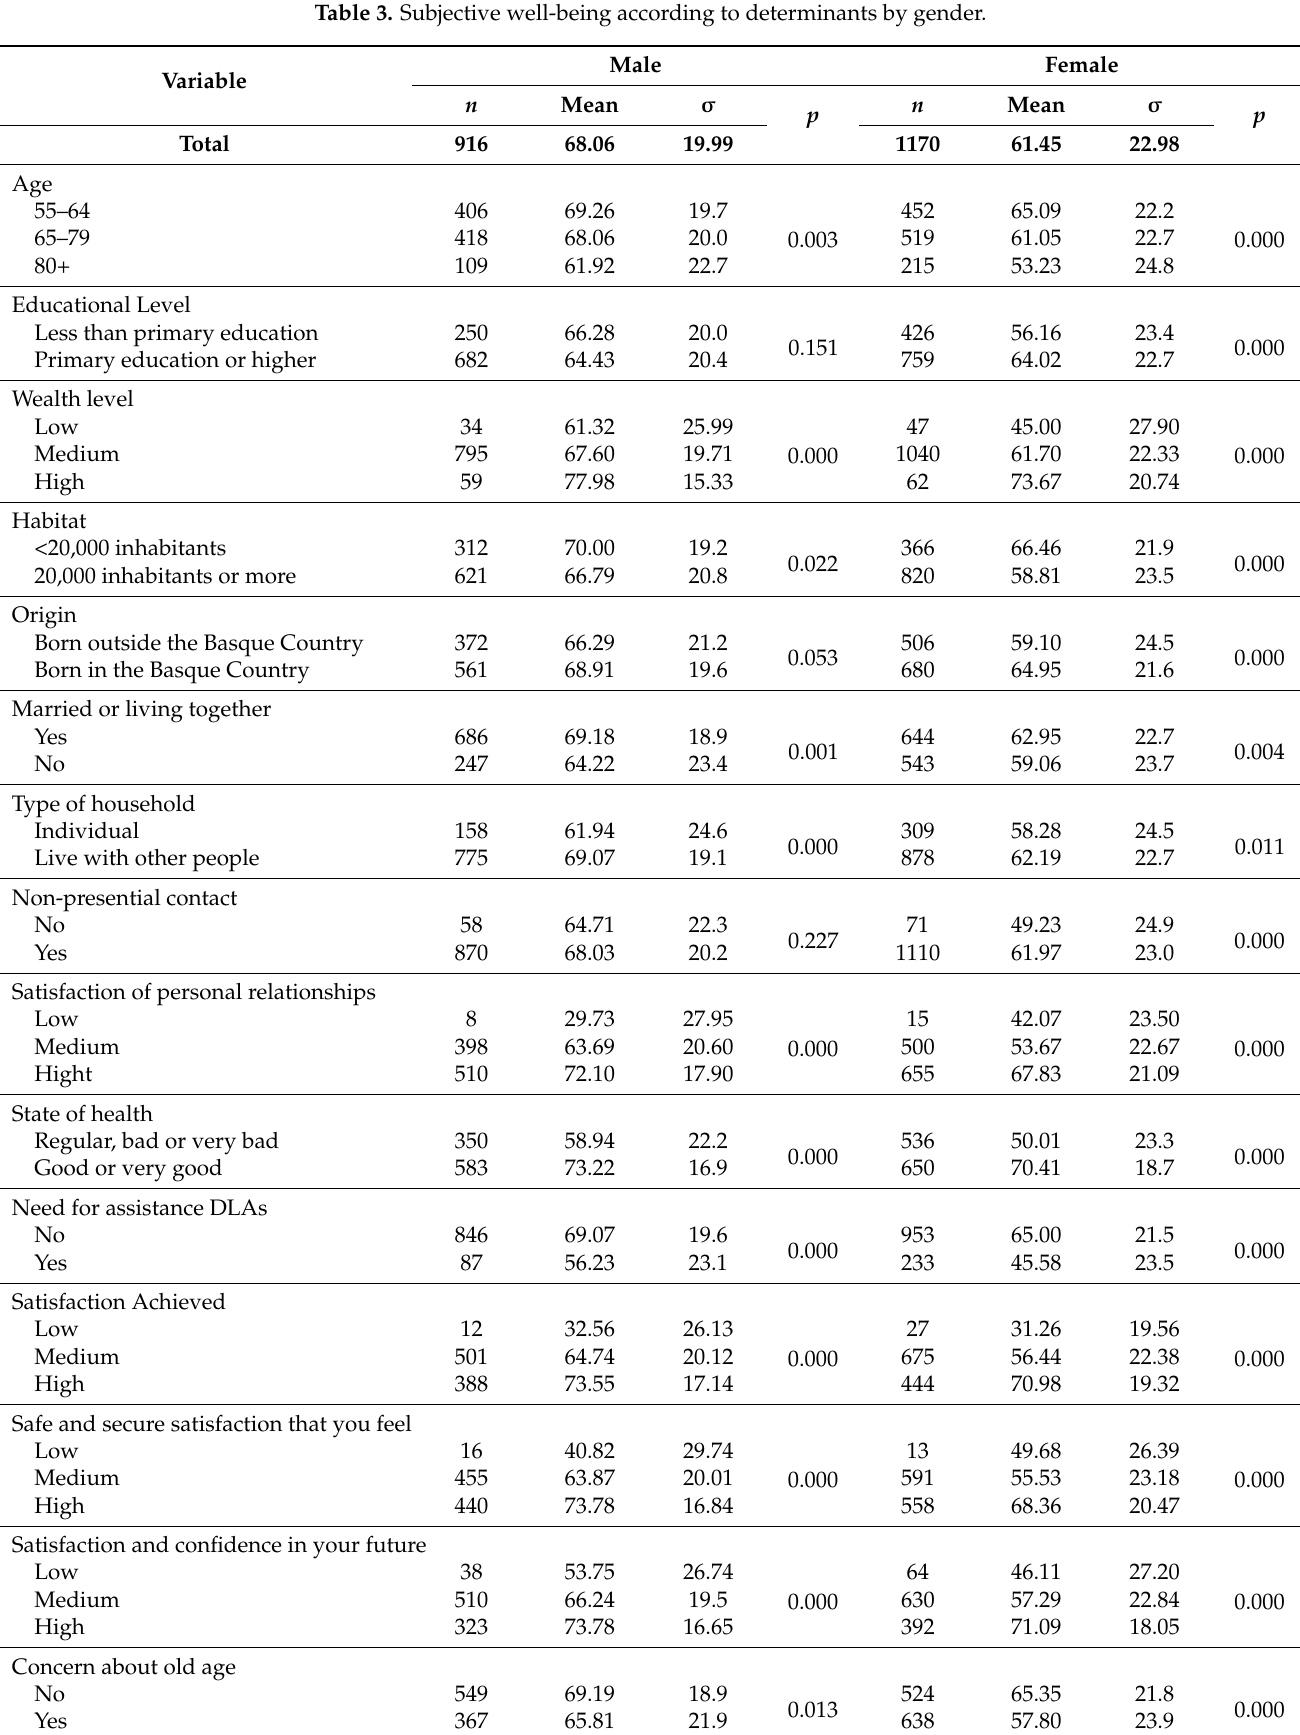
Table 3. Subjective well-being according to determinants by